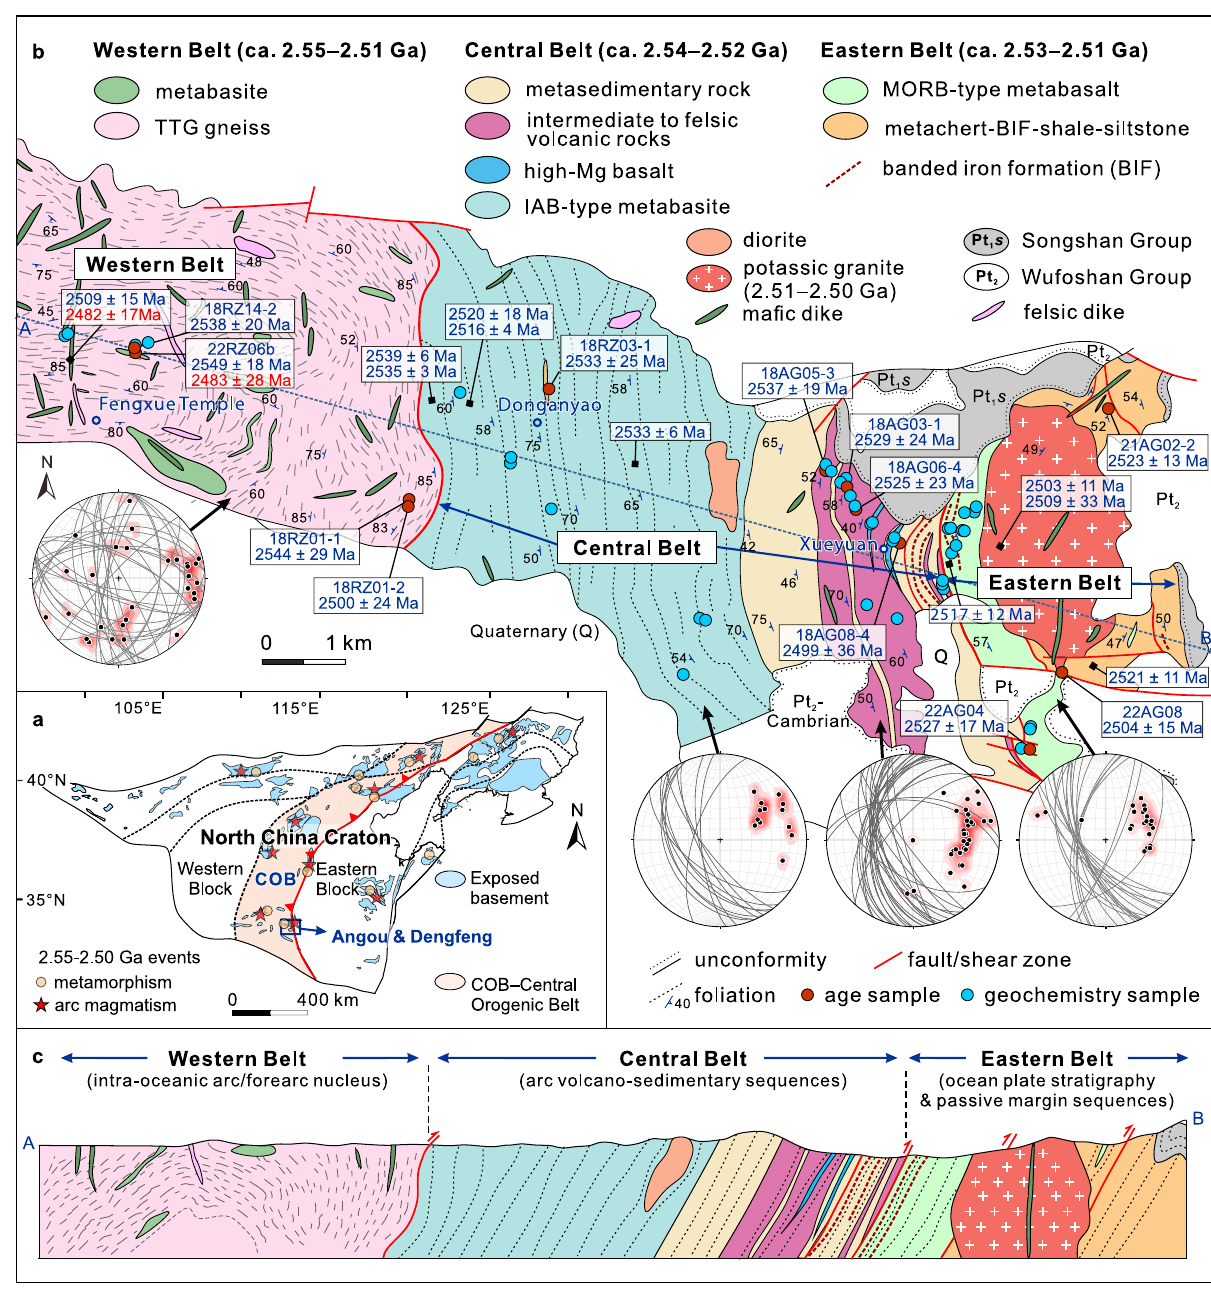
Fig. 1 | Geological maps and lithological-structural relations. a Simpli fi ed tec- tonic map showing the tectonic framework of the North China Craton (NCC, modi fi edfromrefs.18,70). b GeologicalmapoftheAngouComplexinthesouthern NCC (modi fi ed from ref. 23). Three lithostructural belts are shown: the Western, Central and Eastern belts, along with new and previously-reported age data (see